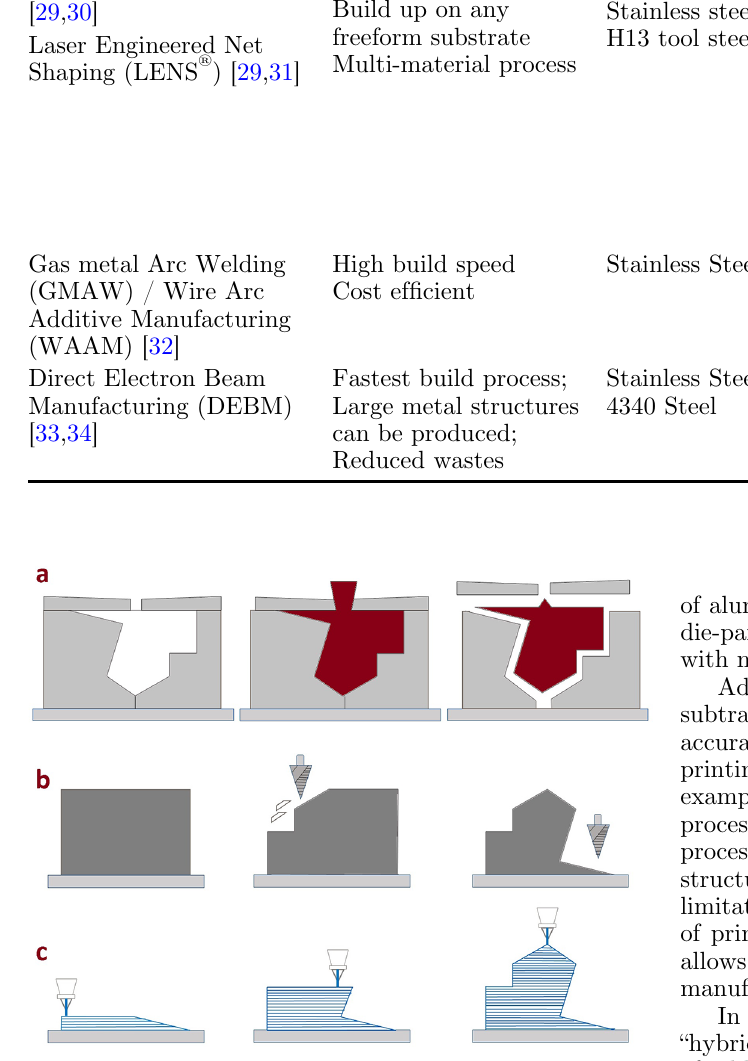
Fig. 2. Manufacturing techniques: 1 – casting; 2 – subtractive; 3 (cid:1) additive